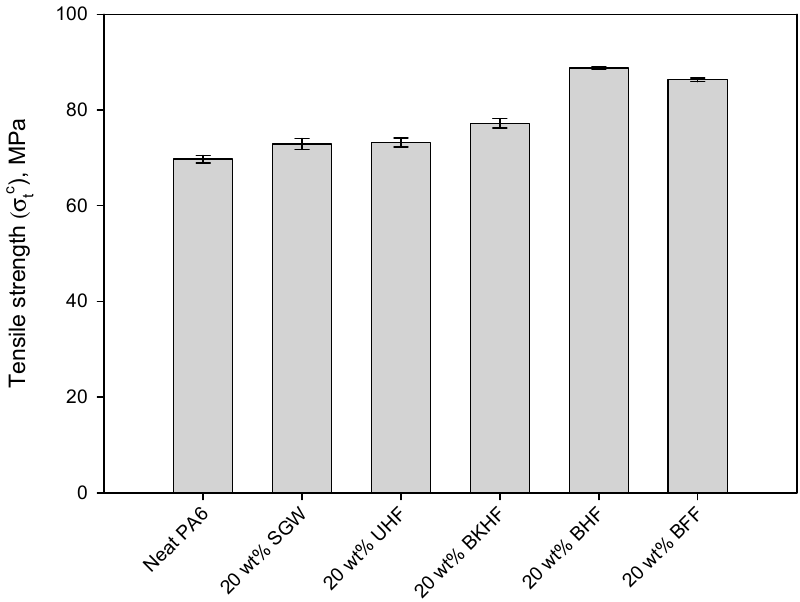
Figure 2. Tensile strength of neat polyamide 6 (PA6) and PA6-composites containing 20 wt % of stone groundwood pulp (SGW), untreated hemp filaments (UHF), bleached kraft hardwood fibers (BKHF), bleached hemp fibers (BHF) and bleached flax fibers (BFF).